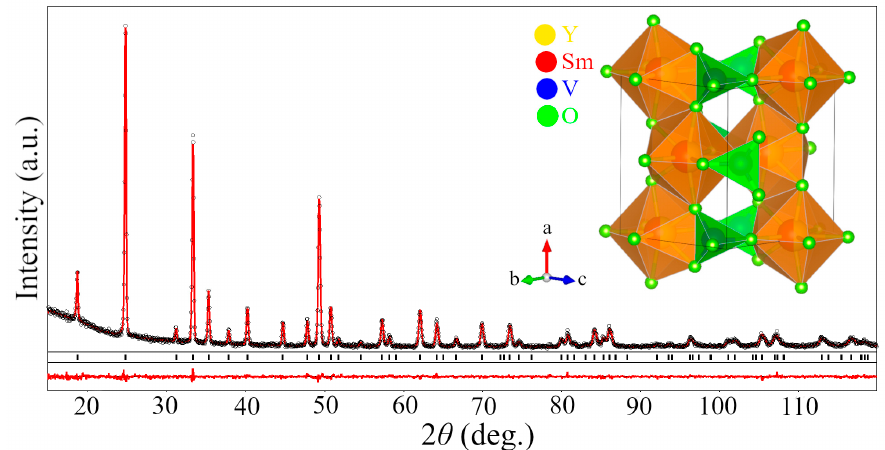
Figure 2. Graphical results of Rietveld refinement of Y 0.5 Sm 0.5 VO 4 structure. Experimental XRD pattern (black circles) is shown in comparison with the calculated profile (red line). Short vertical bars indicate positions of Bragg’s maxima in space group I 4 1 / amd . Inset shows visualization of Y 0.5 Sm 0.5 VO 4 zircon-type structure as chains of alternating VO 4 tetrahedra and Y/SmO 8 polyhedra. The refined structural parameters of the Y 0.5 R 0.5 VO 4 ( R = Sm, Tb, Dy, Ho, Tm, Yb, Lu) solid solutions and corresponding interatomic distances and angles in the zircon-type Y 0.5 R 0.5 VO 4 structures